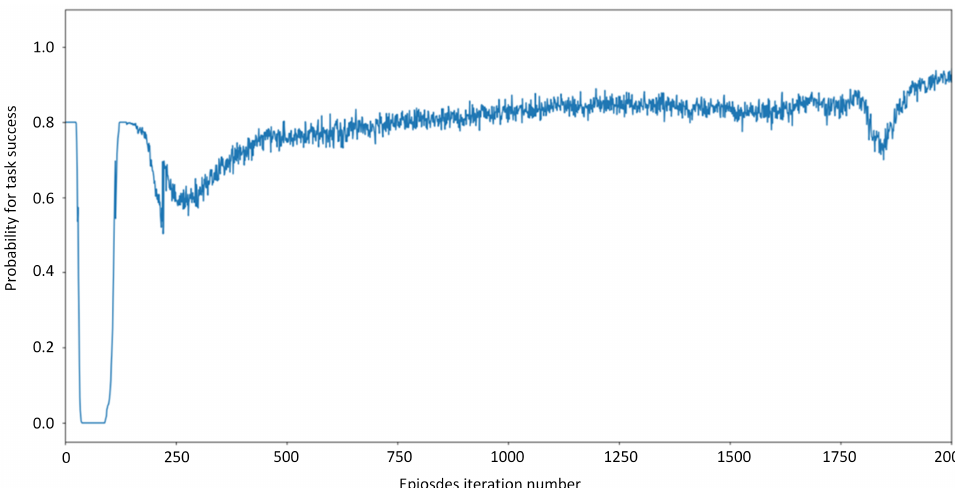
Figure 7. Curve for task success